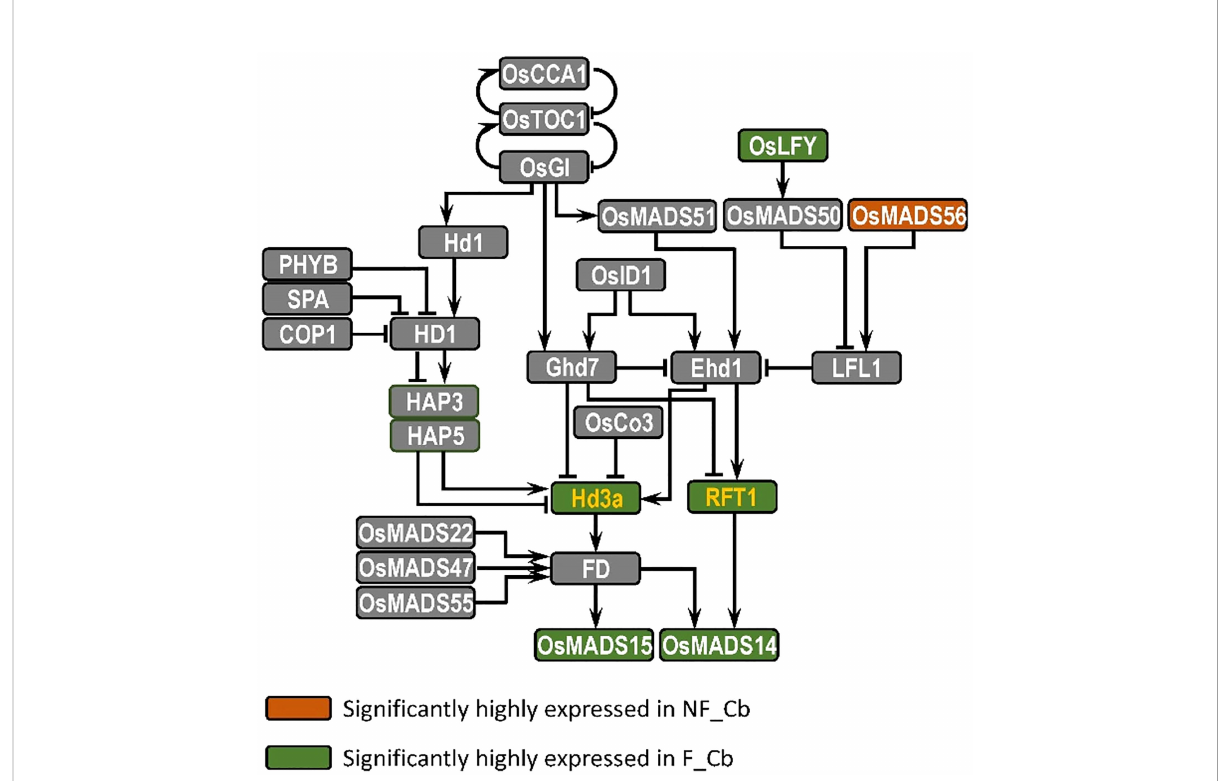
FIGURE 9 Mapping of DE genes in fl owering and non fl owering culm buds in B. oldhamii ‘ Xia Zao ’ reveals the conserved evolution of photoperiod pathway. The yellow color represents integrated node